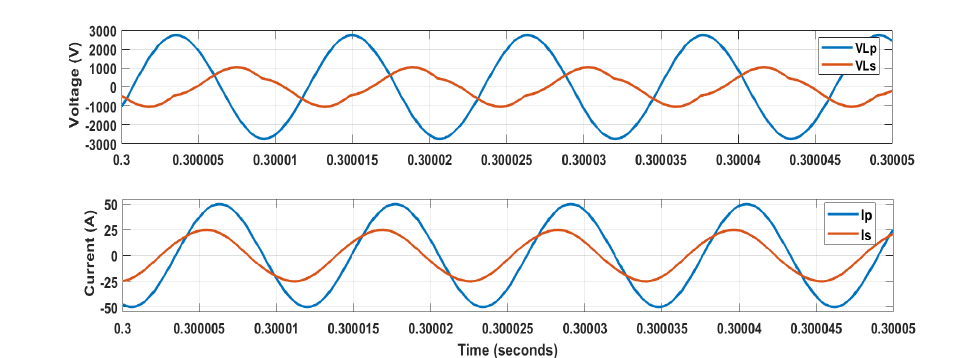
Figure 11. Voltage and current waveform of the inductive track at M = 25 µ H and f = 87.7 kHz.